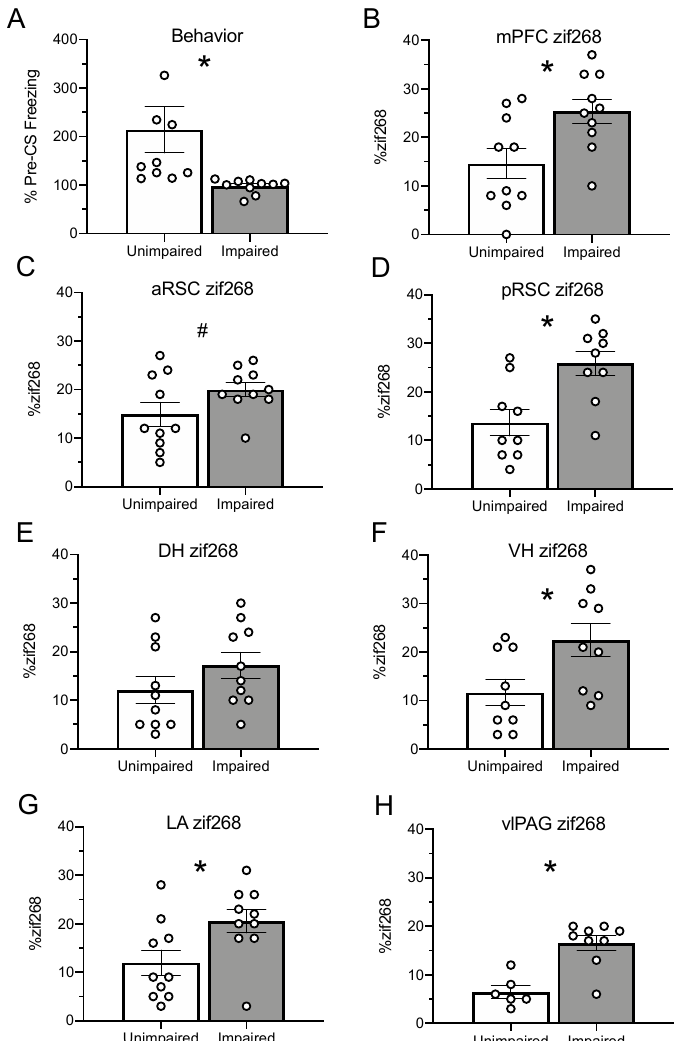
Figure 4. Animals were divided into two groups (high freezers and low freezers) based on a median split of performance in the Post-CS (conditional stimulus) period during the retrieval test. Results from the Post-CS period during the retrieval test (mean and SEM) are shown in Panel ( A ), where impaired animals froze less than unimpaired animals. Panels ( B – H ) show zif268 expression reported as a percentage (mean and SEM) of total DAPI present in the same section. Impaired animals had increased zif268 relative to unimpaired in the mPFC ( B ). While there was a trend in the aRSC ( C ), impaired animals showed increased zif268 in the pRSC ( D ). No di ff erences were seen in the DH ( E ), but impaired animals had increased zif268 relative to unimpaired animals in the VH ( F ). This finding held in the LA ( G ) and the vlPAG ( H ). Asterisks indicate p < 0.05; pound signs indicate p < 0.10. White dots represent individual rats.